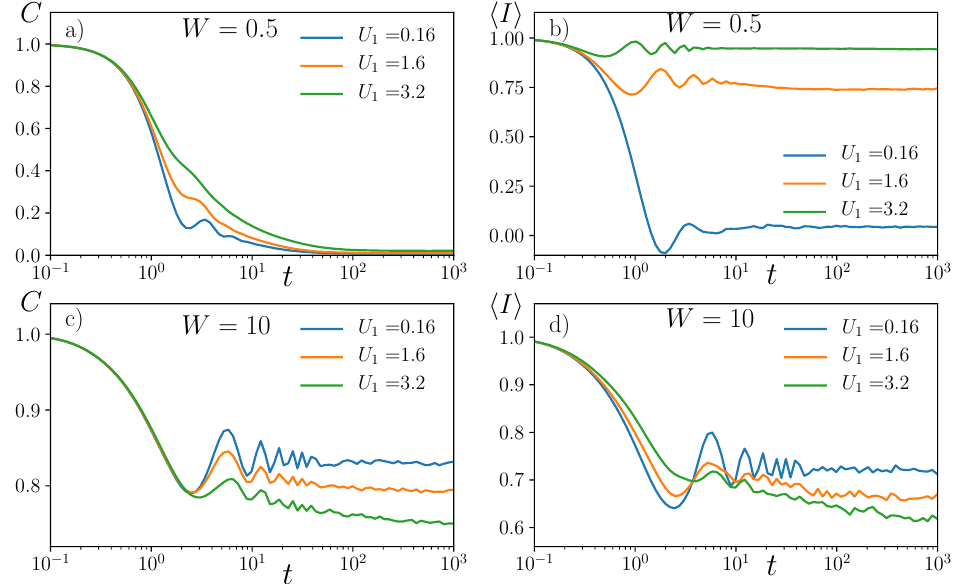
Figure 9: Time evolution of the correlation function C ( t ) , Eq. (9), [ panels a) and c) ] and the imbalance 〈 I 〉 , Eq. (6) [ panels b) and d) ] for different values of long-range interactions U . Top row [ panels a) and b) ] corresponds to small disorder W = 0.5 1 = 1.6,3.2 the imbalance saturates to finite for which MBL is not expected. Yet, for U 1 〉 . For strong values. The initial state of C ( t ) is a random Fock state, for 〈 I 〉 is | DW 10 disorder [ bottom row, panels c) and d) ] , where MBL is expected, the finite values of the population imbalance correspond to the saturation of C ( t ) . The data have been calculated K = 16 and averaged over 1000 disorder realizations (starting time evolution from different randomly chosen Fock state in calculation of C ( t )